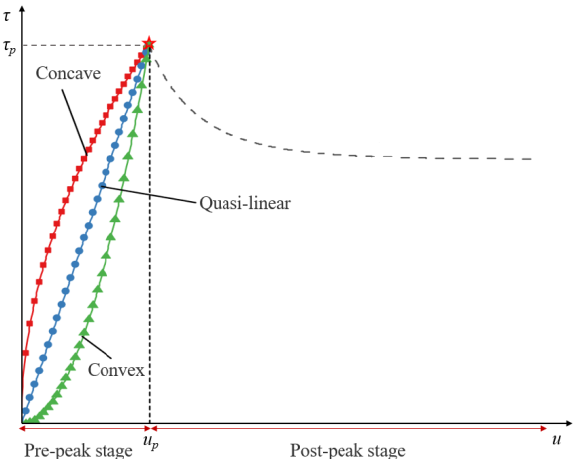
Figure 2. Examples of the pre-peak shear stress - shear displacement curve (modified after [51]).